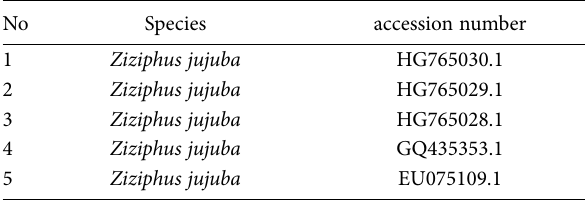
Table 2. The accession numbers of taxa in cp-DNA studies.